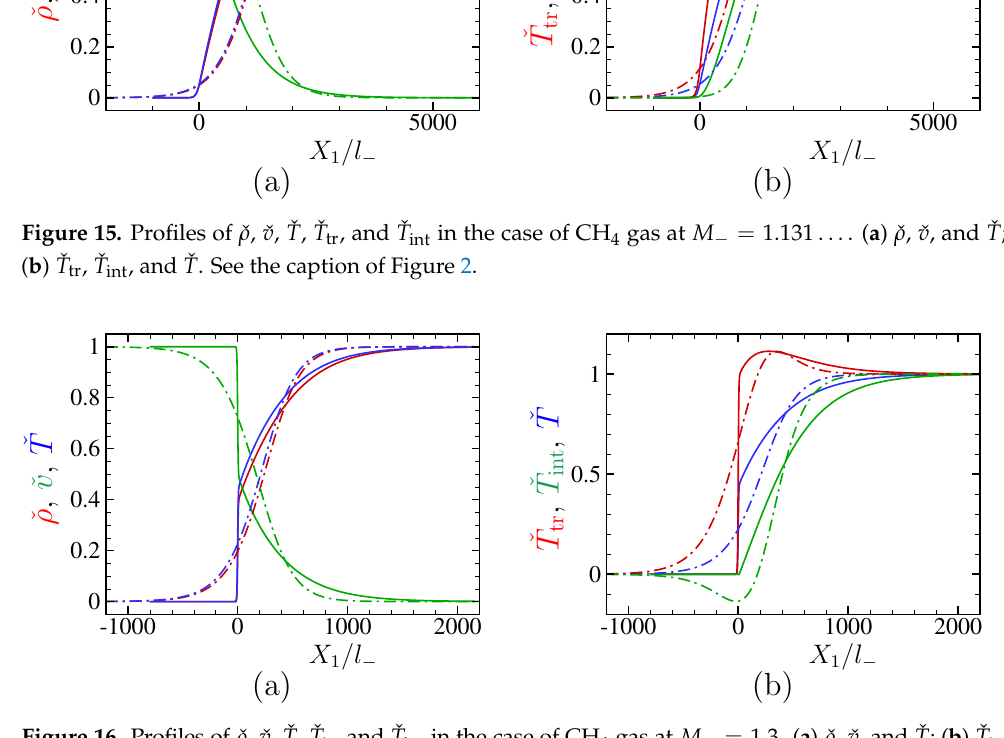
Figure 16. Profiles of ˇ ρ , ˇ v , ˇ T , ˇ T tr , and ˇ T int in the case of CH 4 gas at M − = 1.3. ( a ) ˇ ρ , ˇ v , and ˇ T ; ( b ) ˇ T tr , ˇ T ˇ T . See the caption of Figure 2. int , and